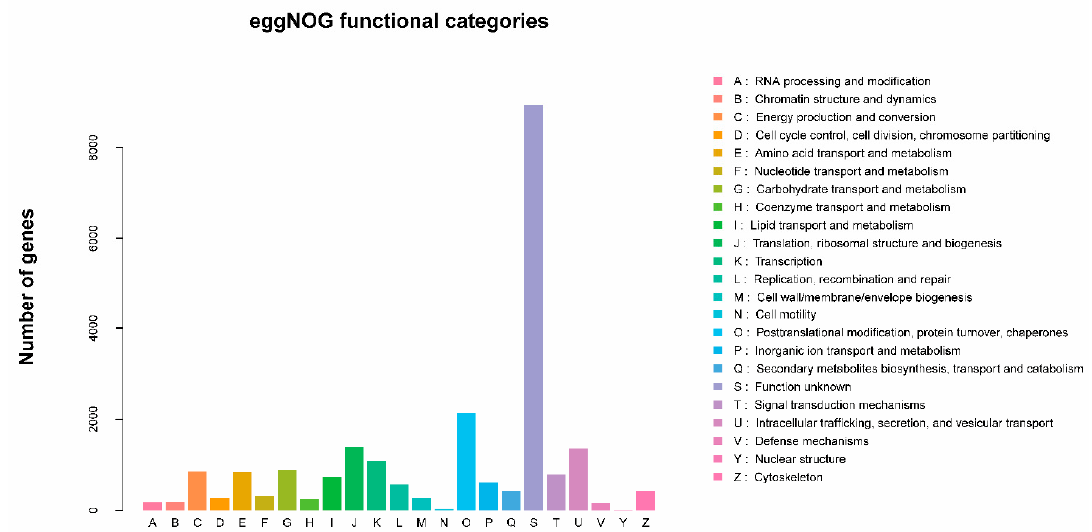
Figure 2. eggNOG functional categories of Frankliniella occidentalis and Frankliniella intonsa unigenes.